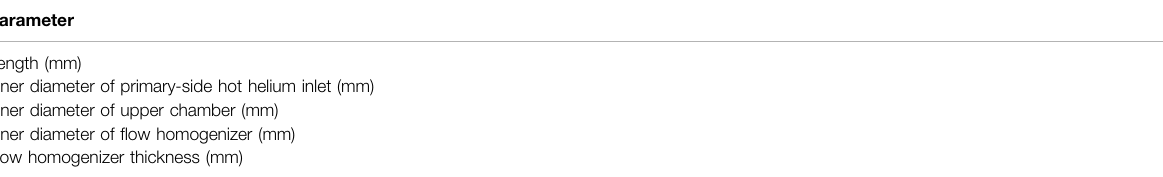
TABLE 1 | Geometrical parameters of the hot helium fl ow homogenizer.